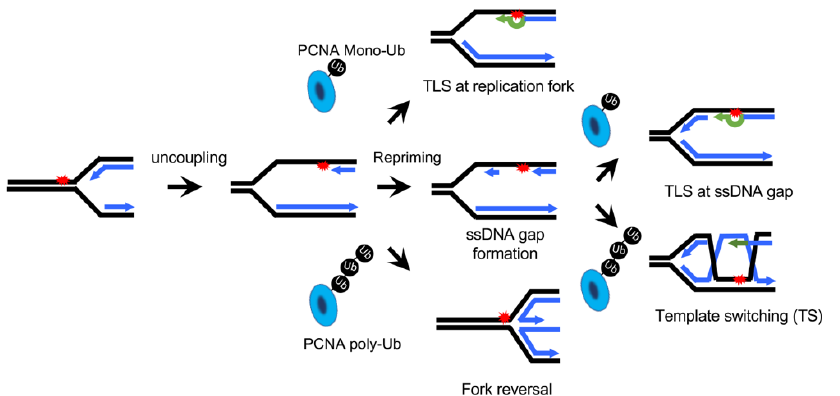
Figure 1. Multiple pathways of DNA damage tolerance (lesion bypass) on the leading strand. A DNA template lesion on the leading strand leads to the uncoupling of the DNA helicase and the replicative polymerase, as well as fork stalling. The lesion can be bypassed right at the stalled replication fork by TLS or, presumably, by fork reversal. Alternatively, the lesion can be skipped by the repriming mechanism, leaving a ssDNA gap behind the replication fork. The ssDNA then can later be filled up by the TLS or TS mechanism.